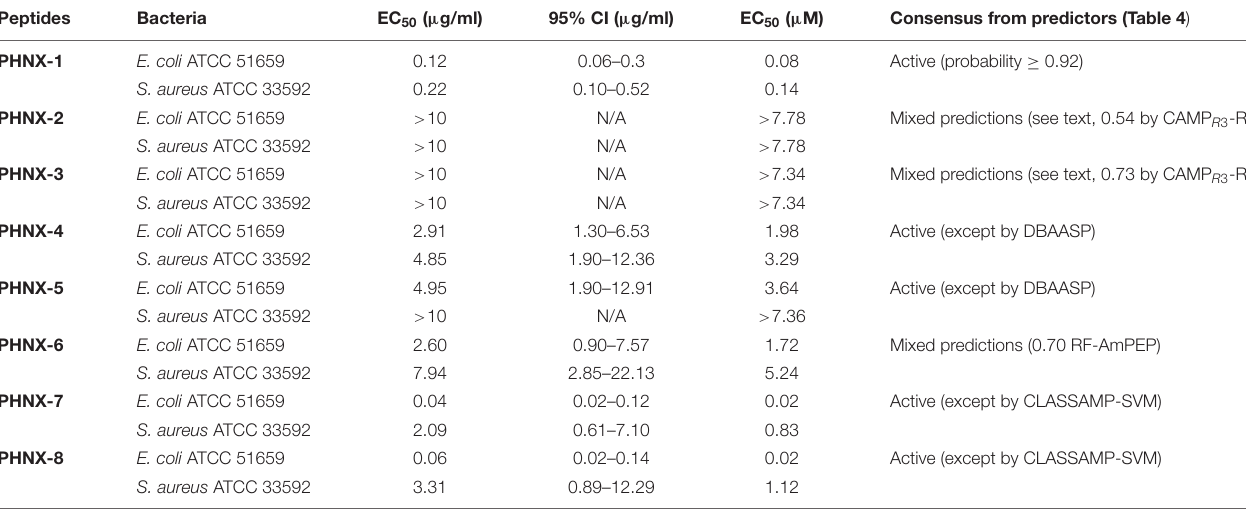
TABLE 6 | Half maximal effective concentration (EC 50 ) of PHNX peptides against multi-drug resistant strains of E. coli and S. aureus .